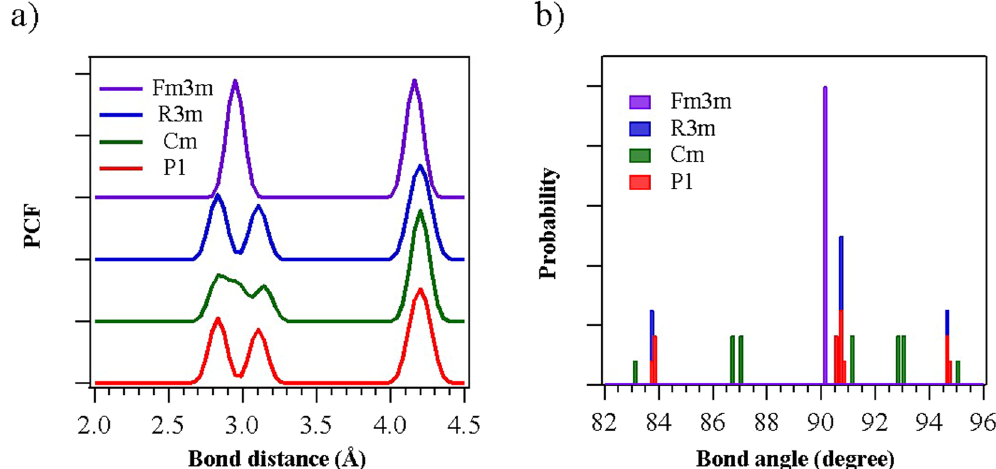
Figure 3. ( a ) Calculated pair correction functions and ( b ) angle distribution, for each of the possible GeTe structures. The geometries of P1 and R3m are very similar, while that of Cm is